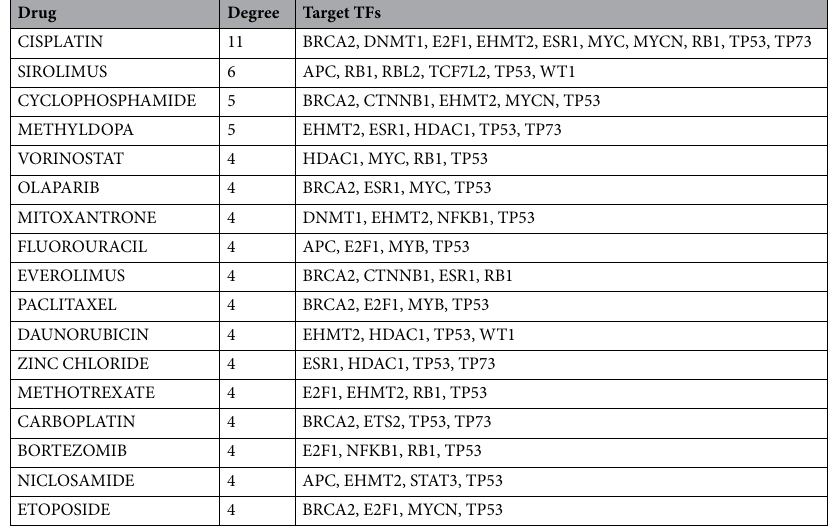
Table 5. High degree drugs in the Drug-TF network. Of all the drugs, only those with degree 4 or higher have been reported.